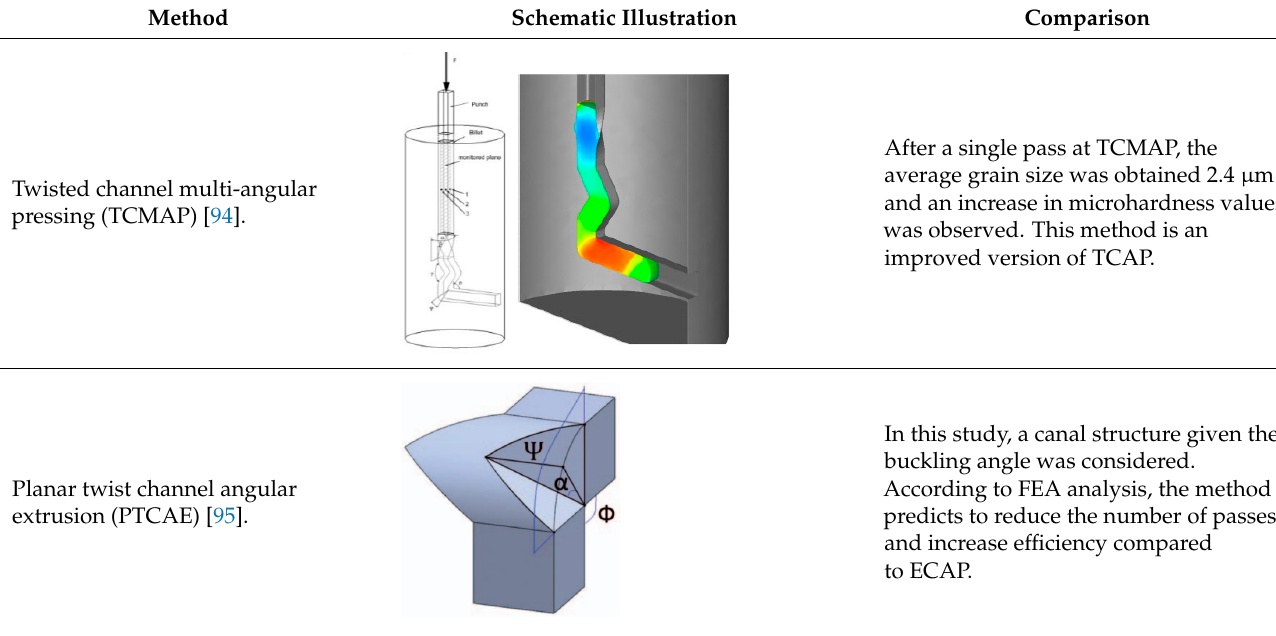
Table 1. Comparison of ECAP and ECAP-derived methods.